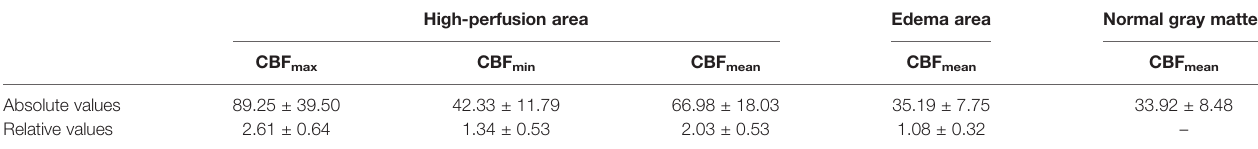
TABLE 3 | The CBF values of sub-volume before radiotherapy (ml/100